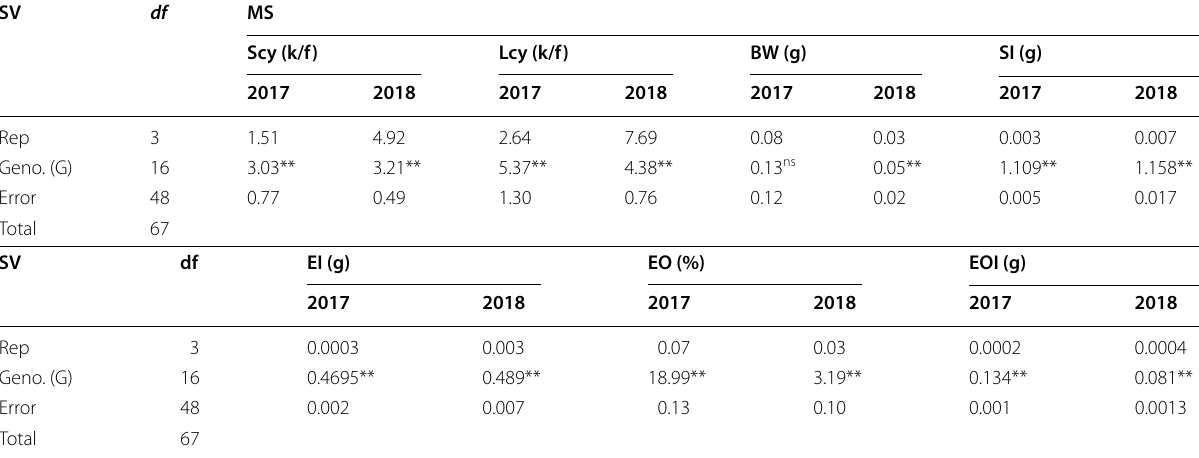
Scy seed cotton yield (k/f), Lcy lint cotton yield (k/f), BW boll weight (g), SI seed index (g), EI embryo index (g), EO embryo oil percentage (%), EOI embryo oil index (g) ns and ** Non significant and Significant differences at 0.01 levels of probability, respectively